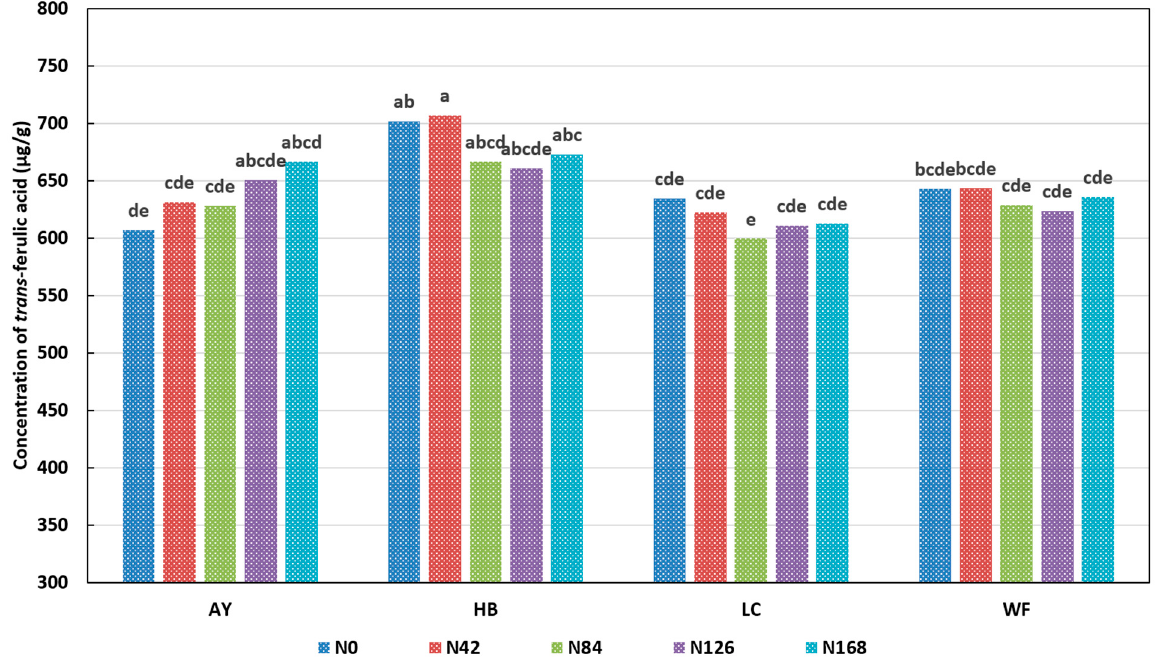
Figure 3. Effect of N*V on concentration of trans -ferulic acid. N: nitrogen rate; V: variety; AY: Anyang; HB: Huaibei; LC: Liaocheng; WF: Weifang. Values with no letter in common are considered significantly different ( p < 0.05).